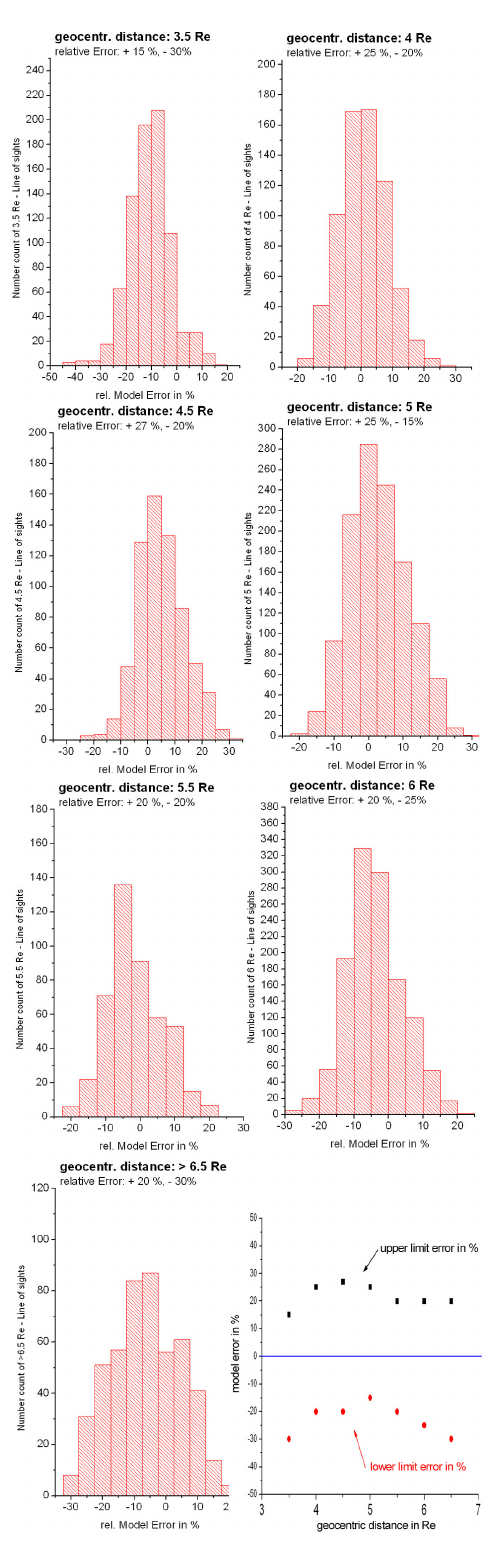
Fig. 6. Relative error histograms for different geocentric distances; the relative max./min. errors in the caption of each figure are the borders of the 2 σ -interval of a Gaussian